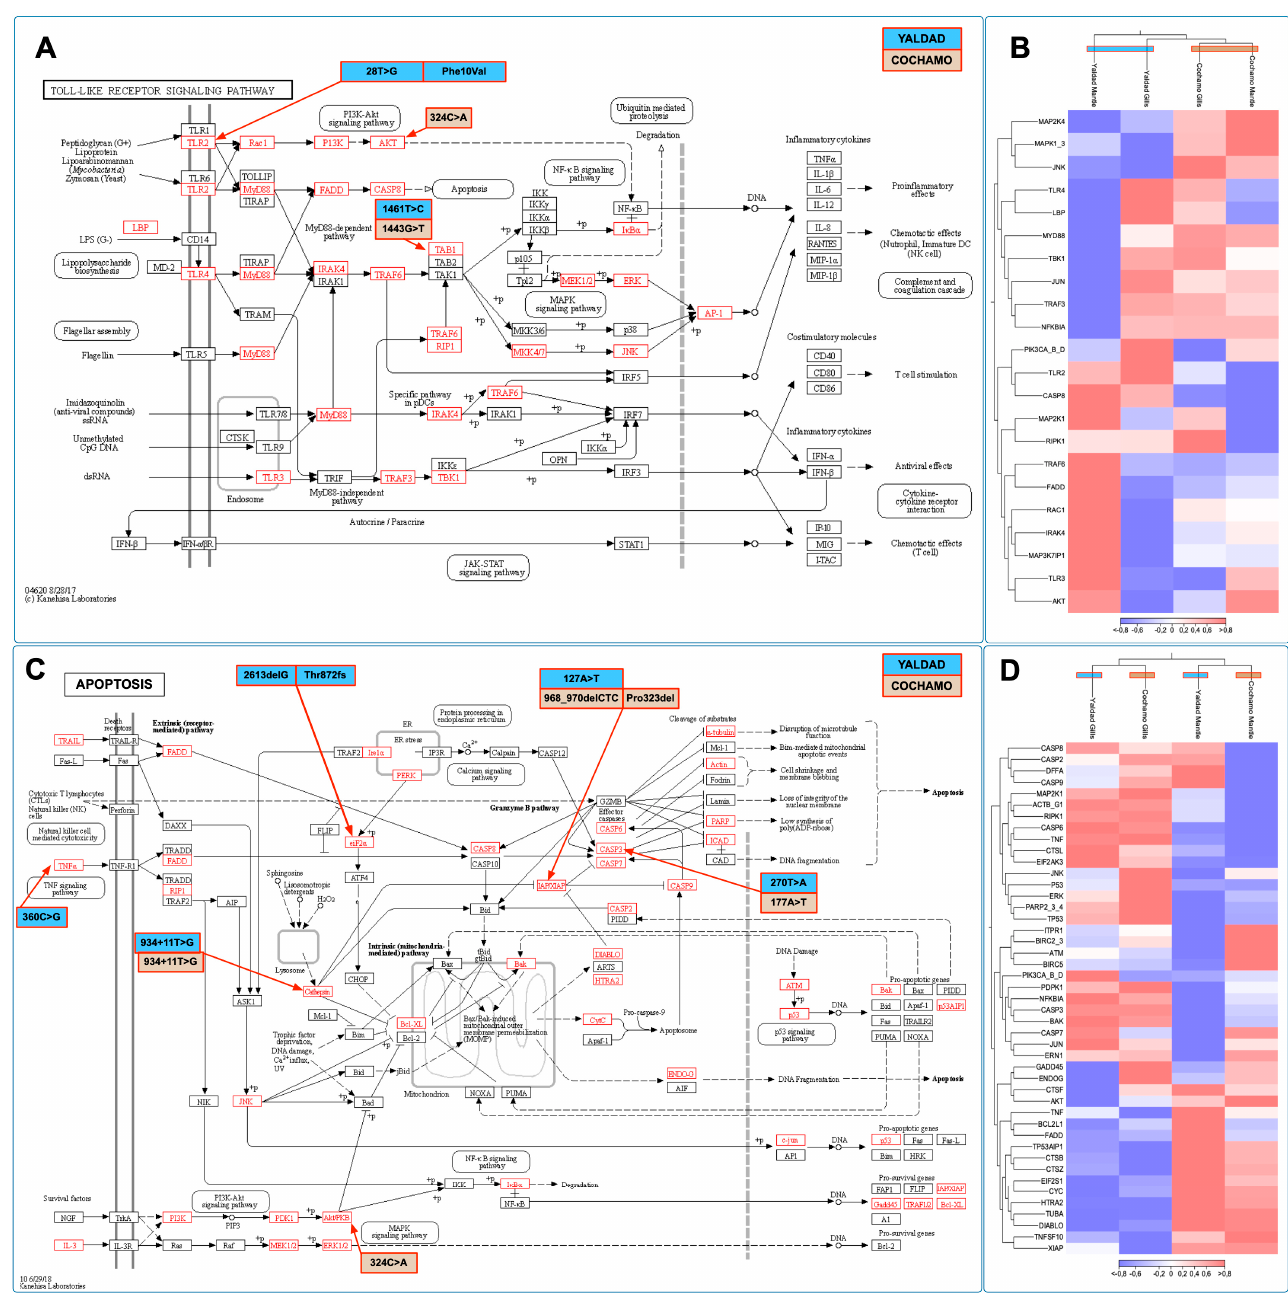
Figure 9. Transcriptome response of the immune system by KEGG pathway analysis and single mutation variant detection between M. chilensis populations. ( A ) Toll-like receptor (TLR) and ( C ) apoptosis signaling pathway comparisons between mussels from Yaldad and Cochamó. Single nucleotide polymorphisms and amino acid changes are shown in blue and brown boxes according to the mussel population. Identified gene families on the KEGG pathways are marked with red in the M. chilensis genome. ( B , D ) Transcriptome patterns of coding genes analyzed in gills and mantle tissue from the Yaldad and Cochamó populations for TLR and apoptosis-related genes. Three replicates were evaluated from each experimental group. The heatmap was based on transcripts per million (TPM) calculation and hierarchical clustering on Manhattan distances with average linkage. Red colors mean upregulated coding genes and blue colors represent downregulated